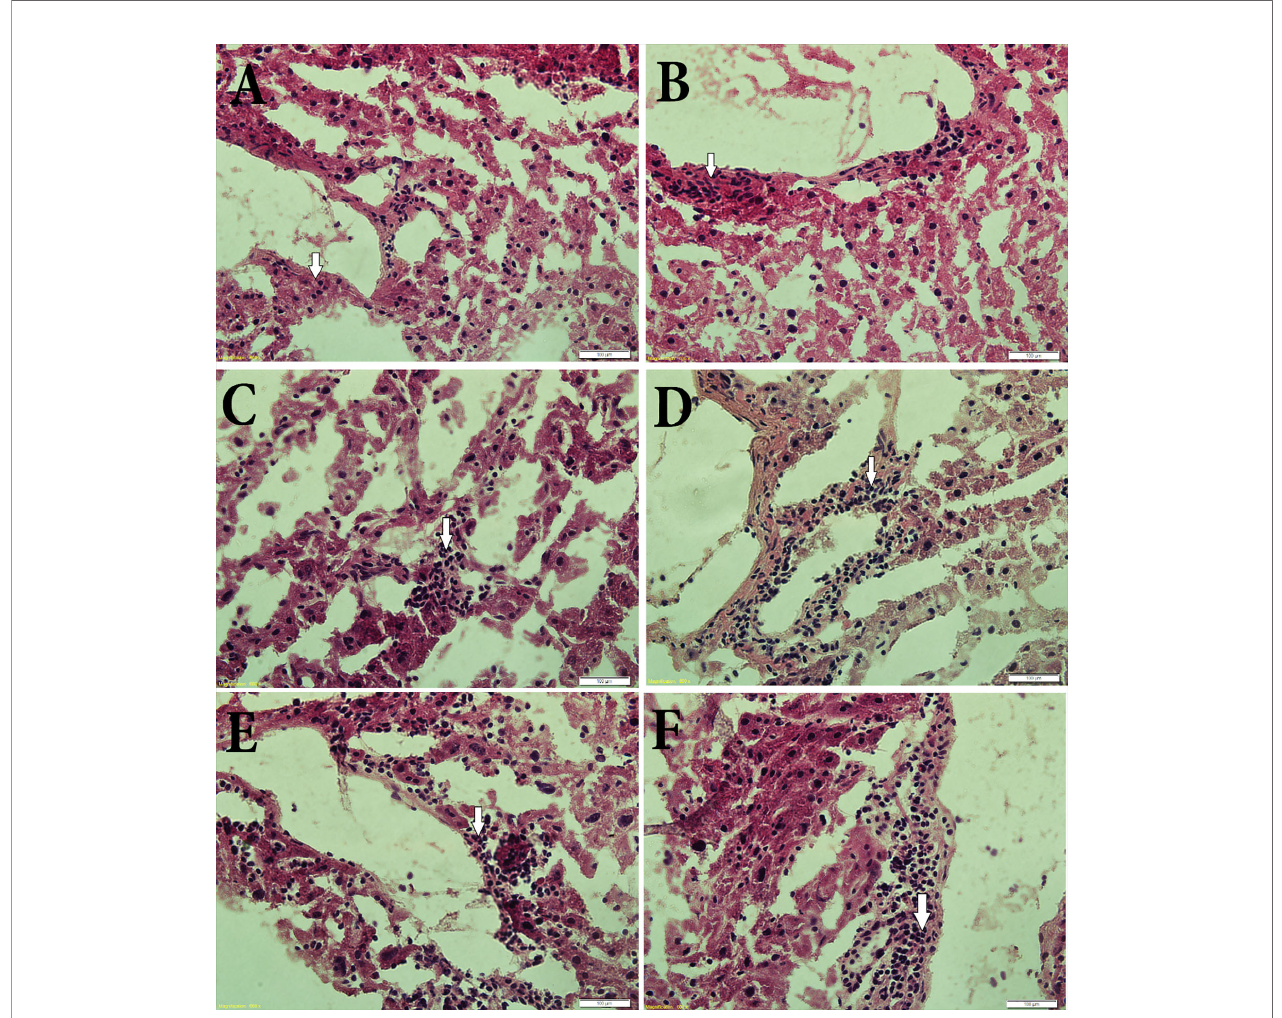
FIGURE 5 | Histological sections of parts of rat liver specimens: (A) control (non-irradiated non-treated with RSV), (B) 2 Gy irradiated control and non-treated with RSV, (C) non-irradiated treated with 10 mg/kg body weight RSV. (D) non-irradiated treated with 100 mg/kg body weight RSV. (E) 2 Gy irradiated pretreated with 10 mg/kg body weight RSV. (F) 2 Gy irradiated, pretreated with 100 mg/kg body weight RSV. Sections show an obvious increase in Kupffer cell boundaries of blood vessels due to pretreatment with 100 mg/kg body weight